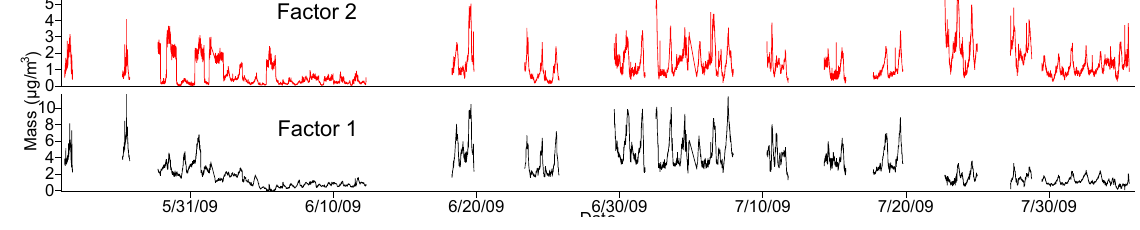
Fig. A6. Time series contributions for the 2-factor solution.